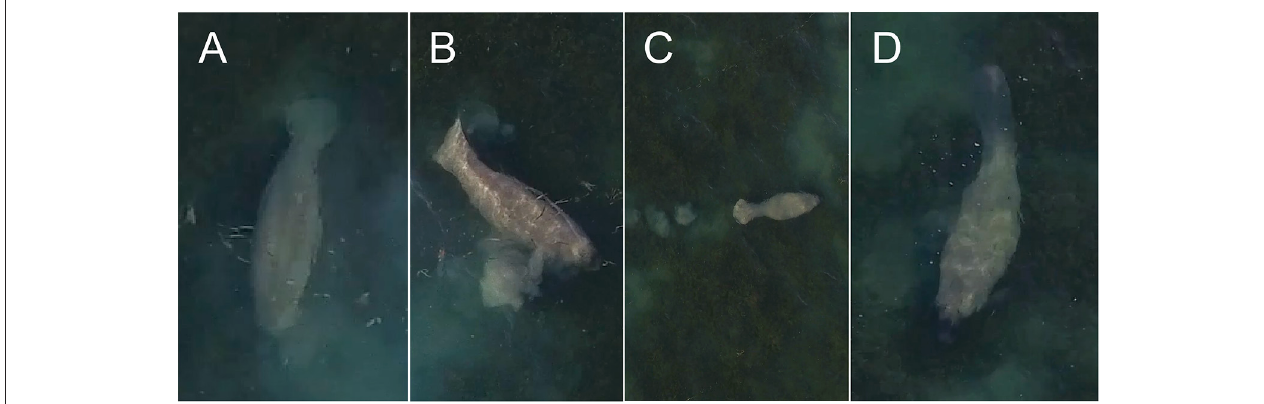
FIGURE 6 | Sequence of response behaviors of an Antillean manatee exposed to a small unmanned aerial system. (A) The feeding manatee was stationary pre-response. (B) Upon detecting the aircraft during direct vertical approach, the manatee began to swim away rapidly (B) leaving a large silt plume and (C) fleeing the area. In some flights, (D) aircraft movements caused manatees to directionally evade the aircraft’s flight path.